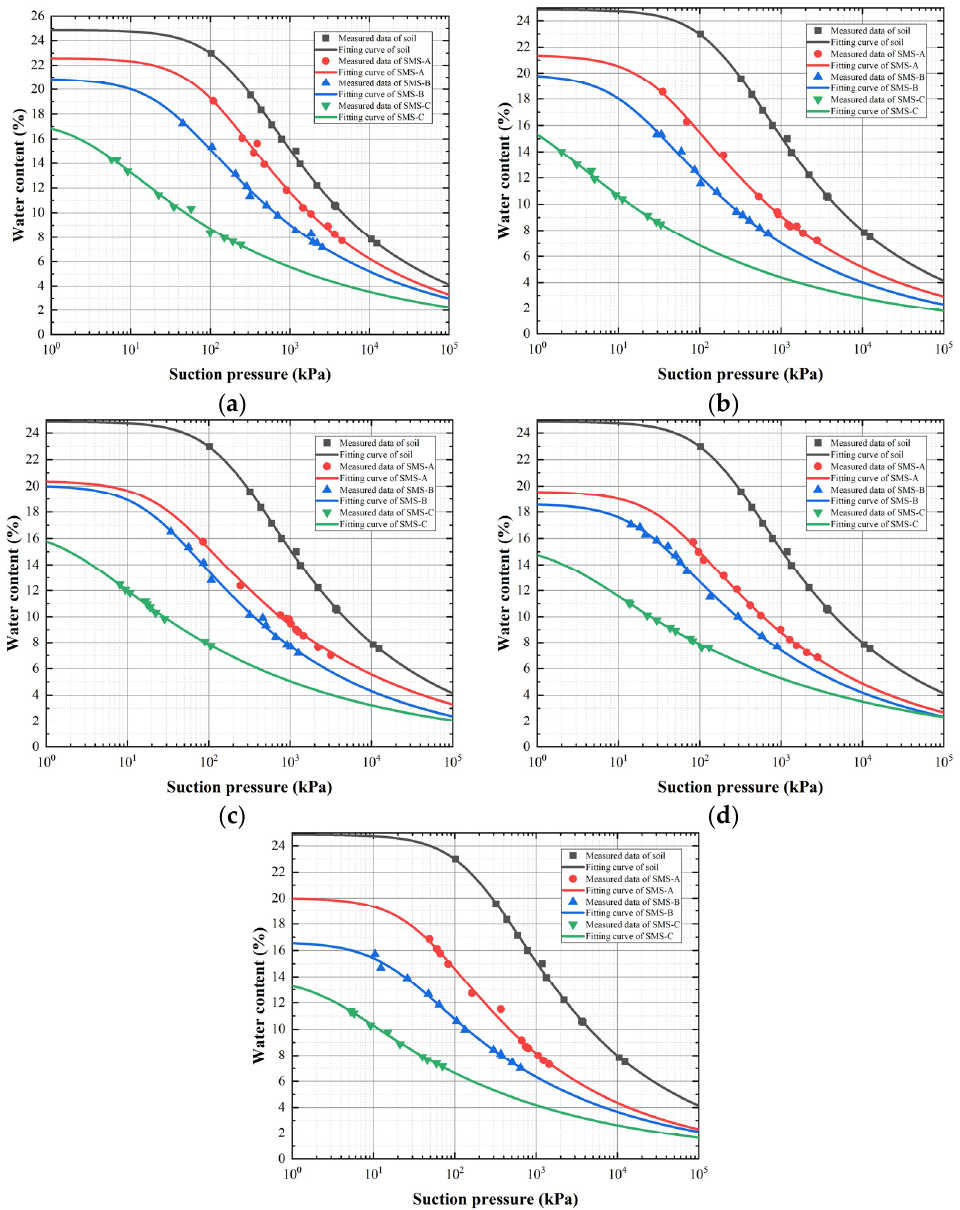
Figure 5. Changes in SWCCs after hydrophobic treatment with different dosages at the same time: